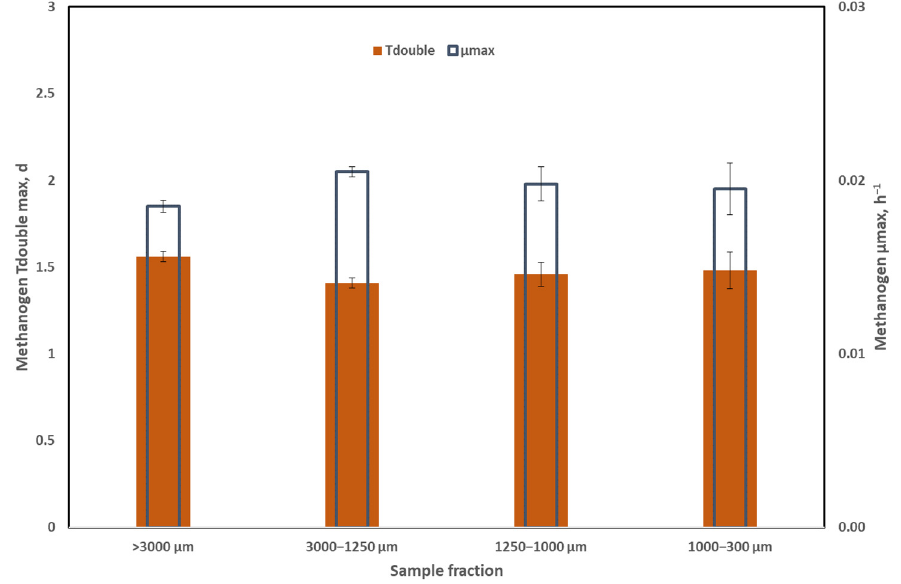
Figure 3. Maximum specific growth rate, µ max, and methanogen doubling time, Tdouble max, estimated from the biochemical methane potential curves of solid fractions collected from sieves with various opening sizes.